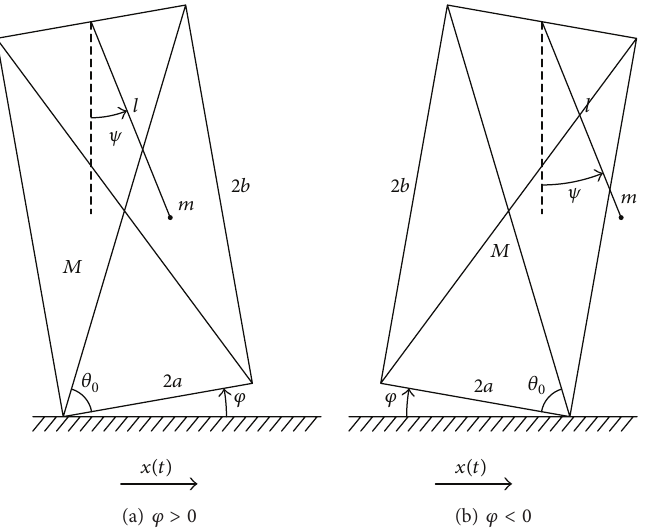
Figure 4: The rocking block with the added pendulum, scheme of